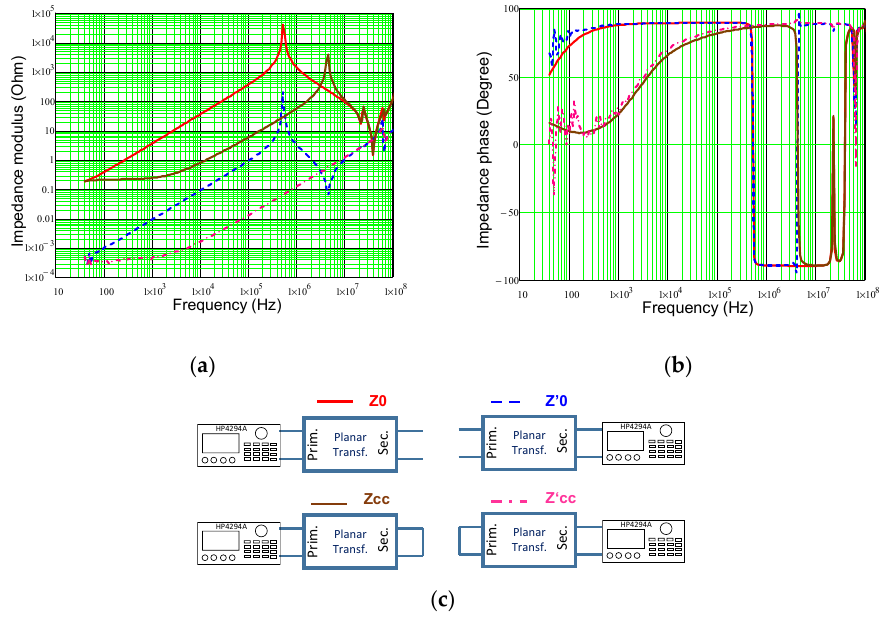
Figure 8. Planar transformer impedance measurements: ( a ) modulus; ( b ) phase; ( c ) measurement configurations.